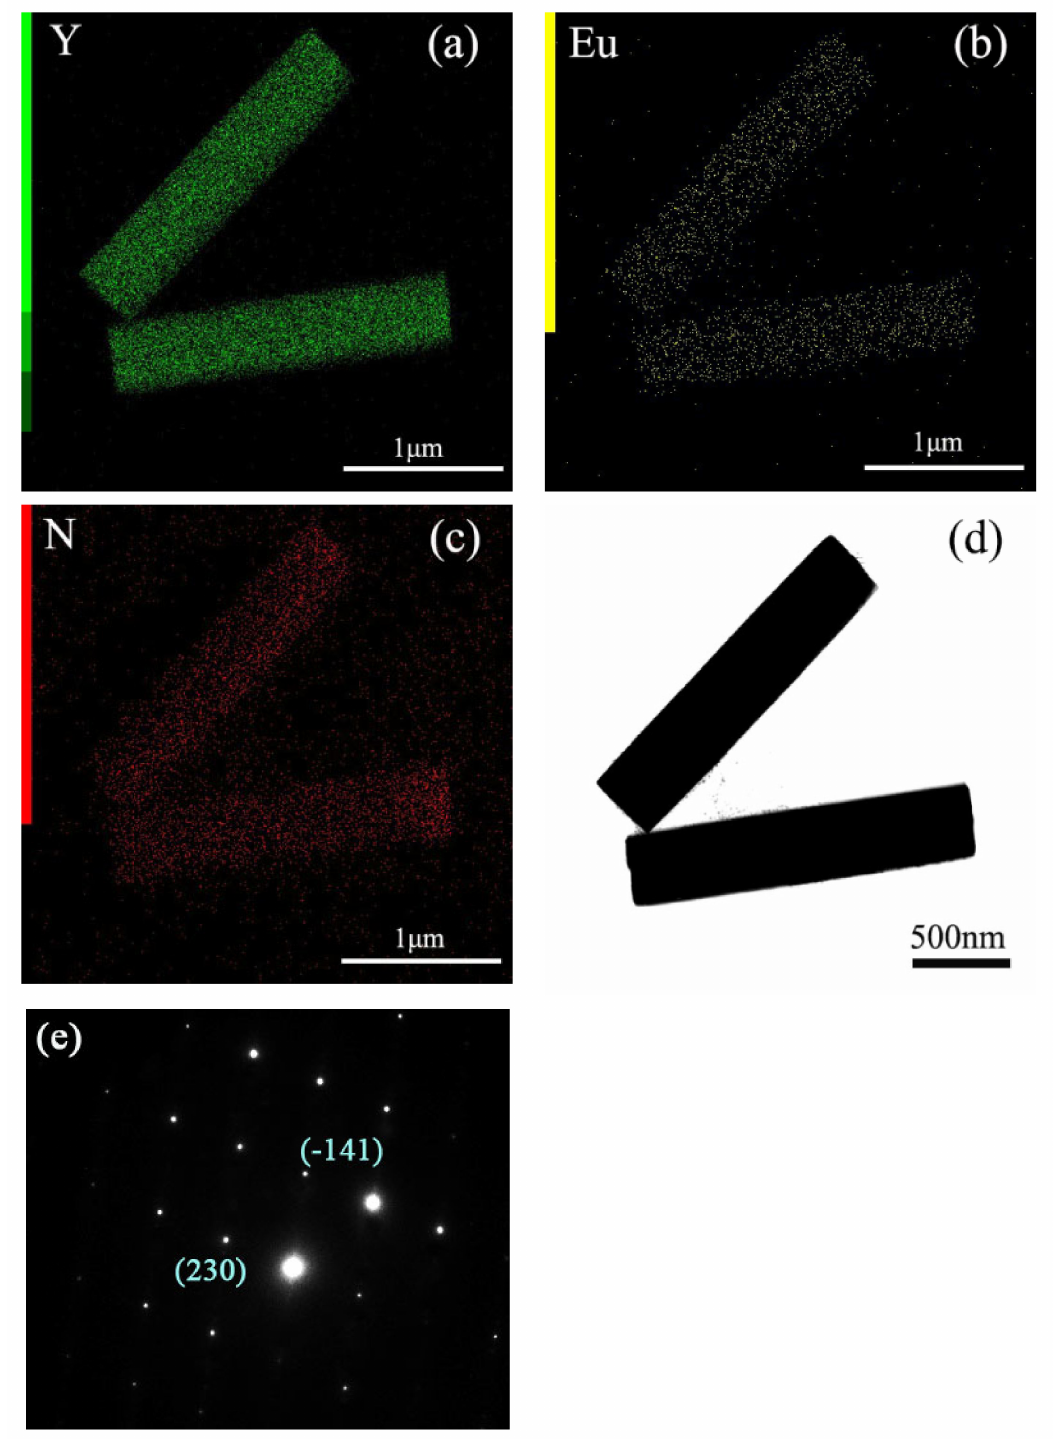
Figure 5. ( a – c ) Elemental mapping, ( d ) TEM image, and ( e ) SAED for